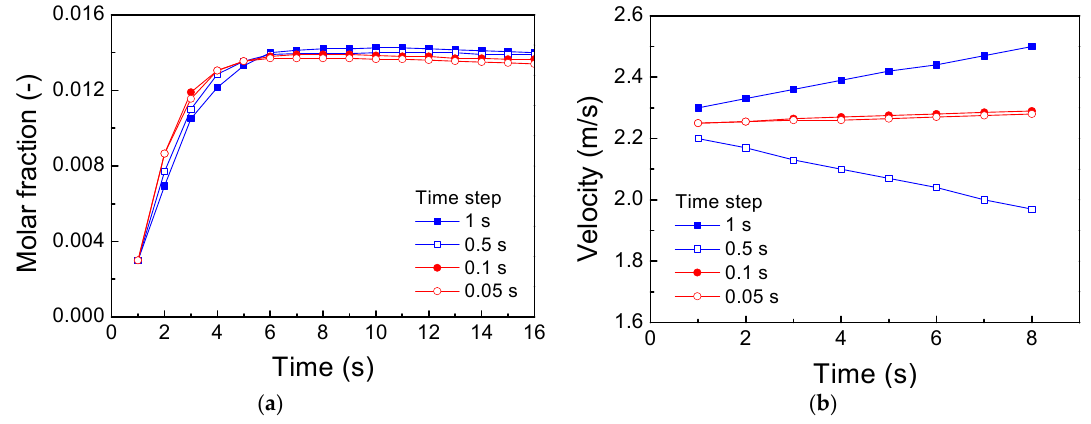
Figure 4. Independence test for time steps: ( a ) concentration and ( b ) velocity evolutions.